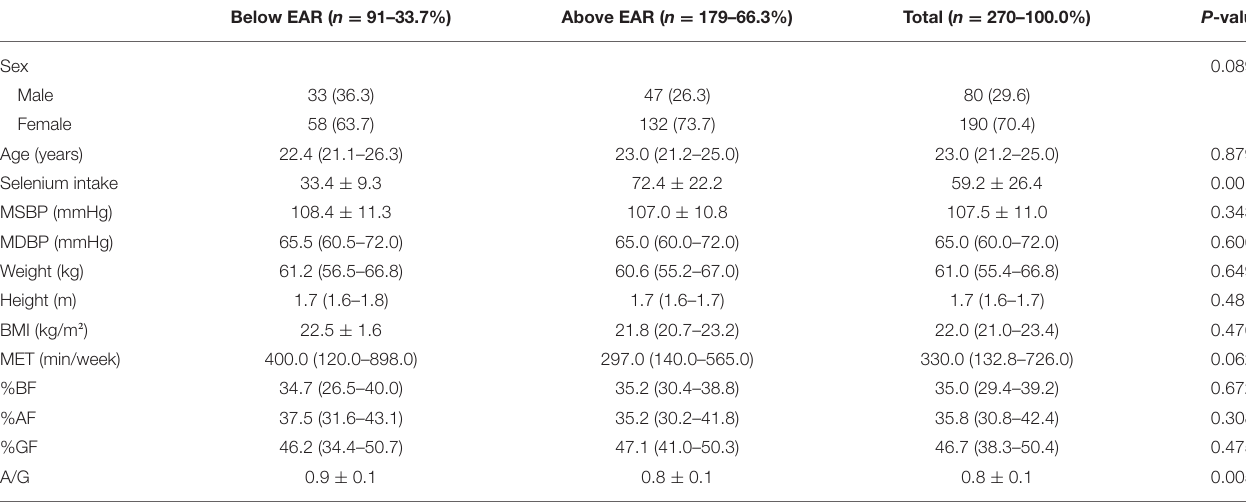
TABLE 1 | Descriptive data of individuals with Normal-Weight Obesity Syndrome, according to the classification of dietary selenium intake. Below EAR ( n = 91–33.7%) Above EAR ( n = 179–66.3%)